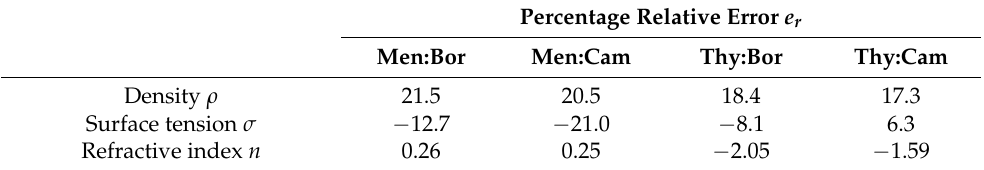
Table 3. Error parameter for each parameter.